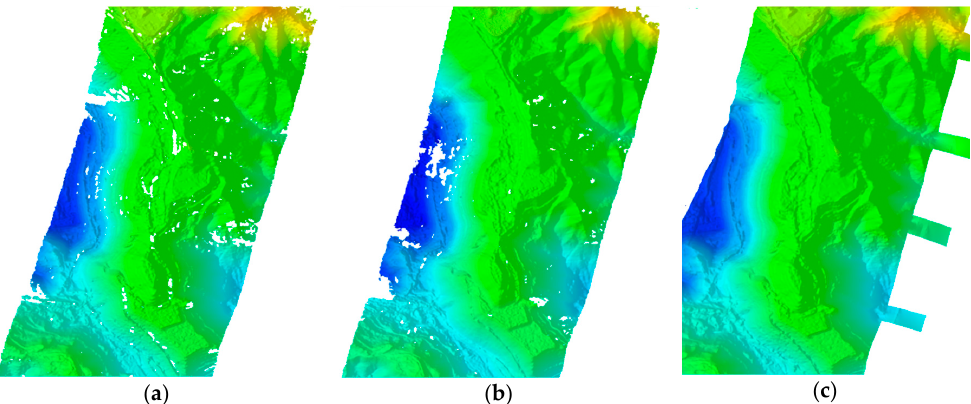
Figure 8. Subset of SkySat shaded DEMs over Morenci Mine using ( a ) backward and nadir images, ( b ) nadir and forwards images, ( c ) backward, nadir and forwards